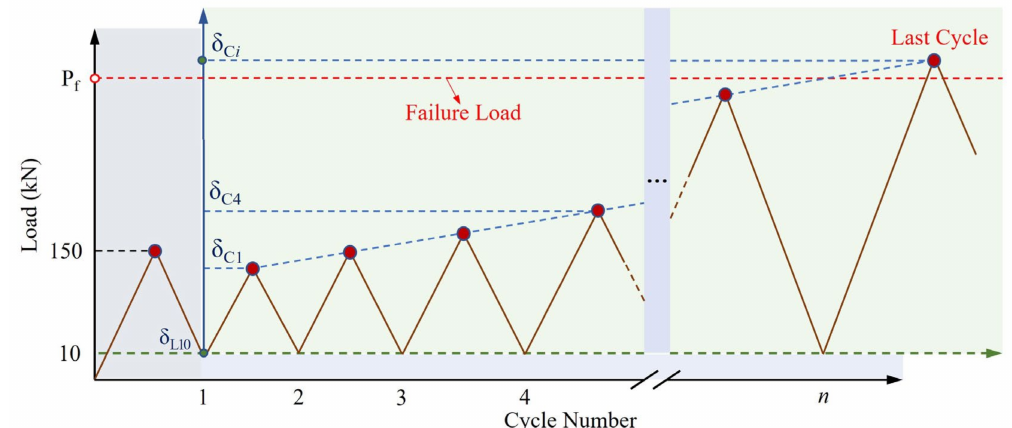
Figure 4. Cyclic loading protocol.